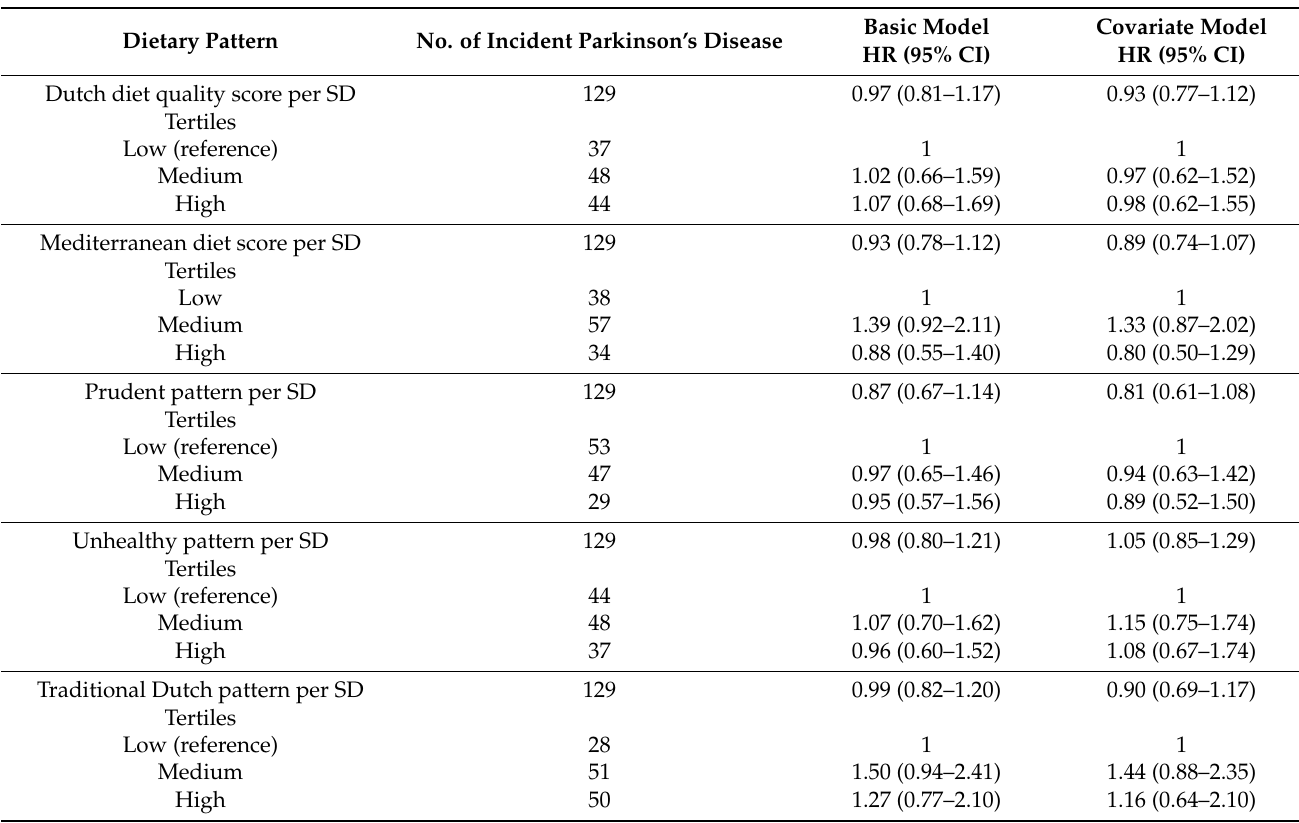
Table 3. Associations between dietary patterns and Parkinson’s disease ( n